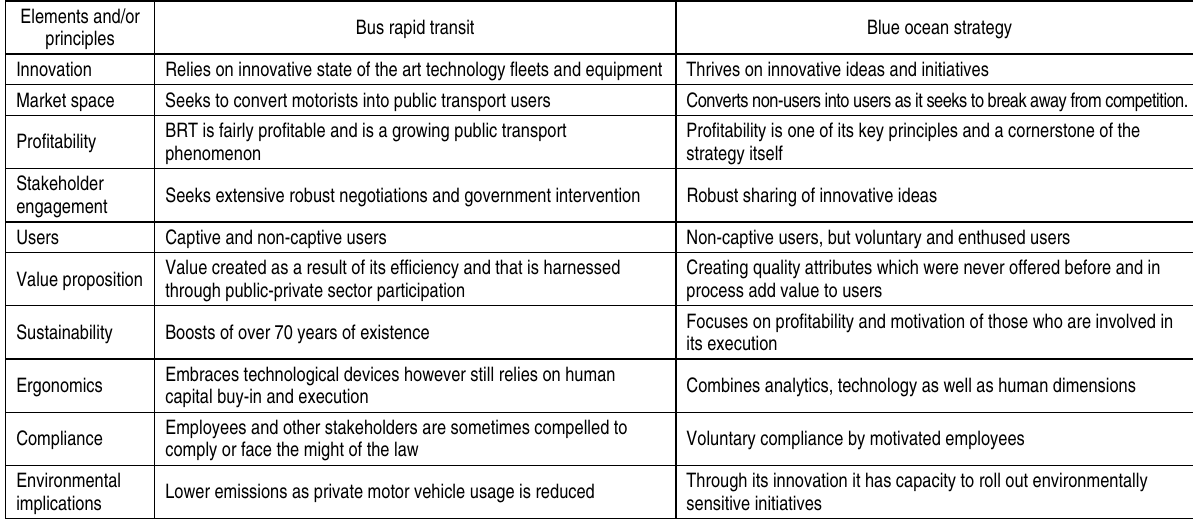
Table 1. BRT and BOS elements and